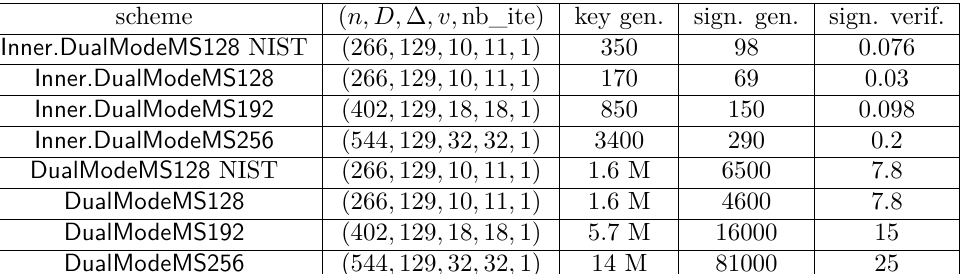
Table 24: Number of mega cycles for each cryptographic operation for DualModeMS . We use a Skylake processor (DesktopS).